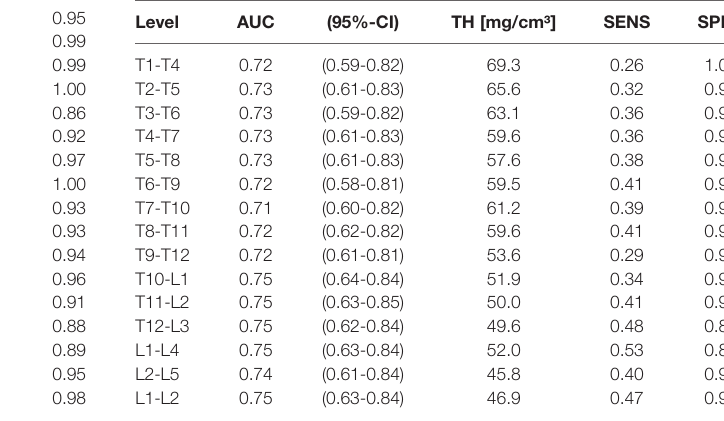
95%-CI), optimal vBMD threshold (TH; mg/cm³), and corresponding sensitivity (SENS) and speci fi city